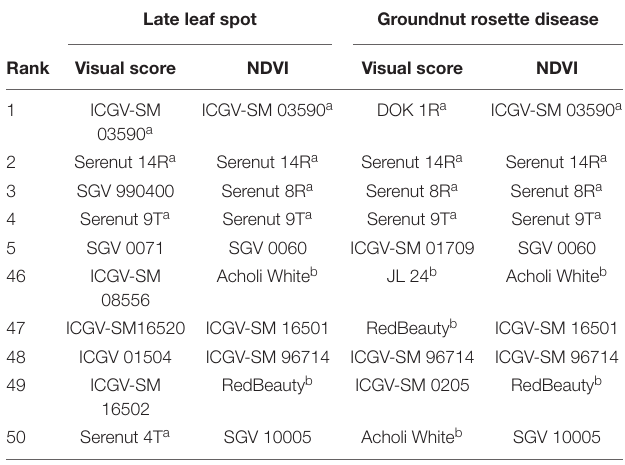
TABLE 5 | Table genotype ranking for LLS and GRD using visual scores and NDVI. The genotype ranking was done using genotype means.